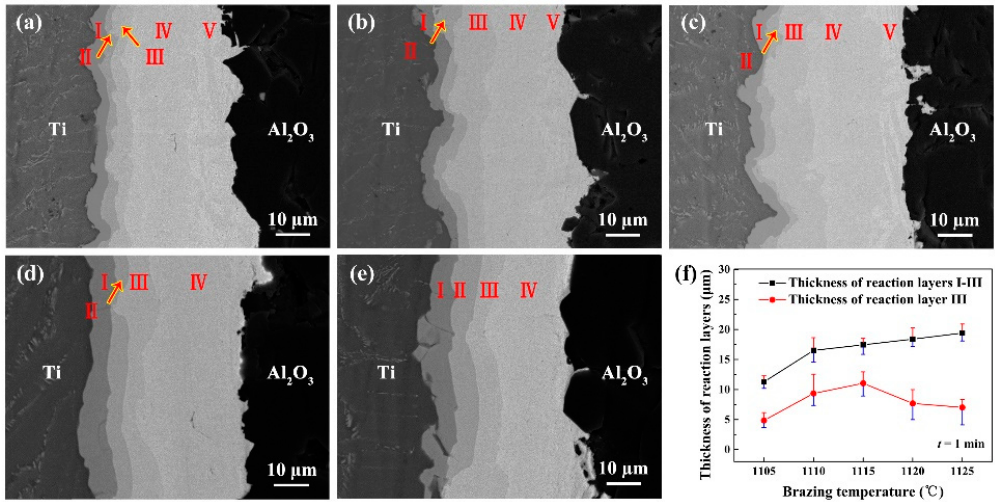
Figure 5. Microstructure of the titanium/Au/Al 2 O 3 joint brazed at different brazing temperature for 1 min: ( a ) 1105 °C, ( b ) 1110 °C, ( c ) 1115 °C, ( d ) 1120 °C, ( e ) 1125 °C, and ( f ) the thicknesses of Ti-Au layers (zone I-III) .